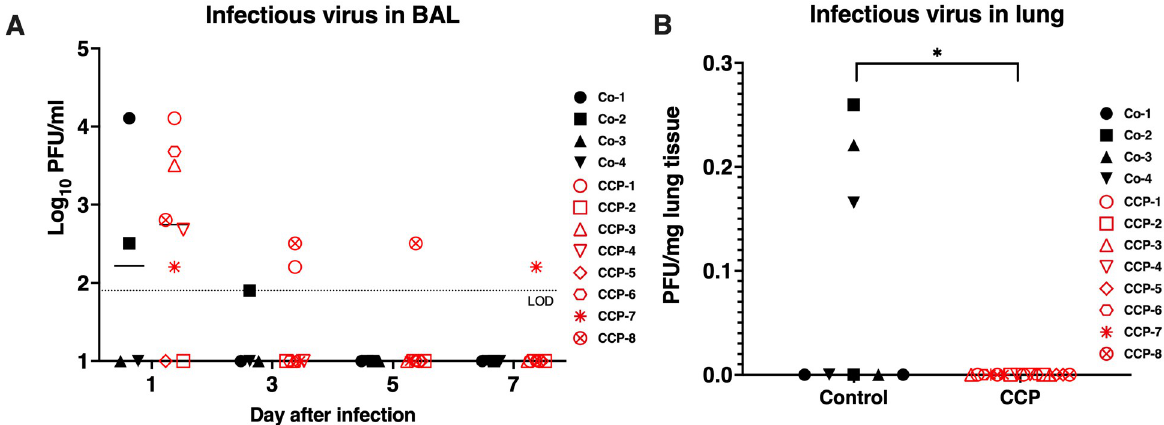
Fig 5. Effect of convalescent plasma on infectious virus titers in BAL and lung tissues. (A) Infectious virus titers in BAL supernatant (expressed as plaque-forming units (PFU) per ml) did not show any difference between the 2 study groups for any of the time points of BAL collection. Lines indicate median values. The dotted line indicates the limit of detection (LOD). (B) Infectious virus titers in lung tissues. For each animal, two snapfrozen lung specimens (one sample per left and right caudal lung lobe) were tested for infectious virus. The only 3 samples with detectable virus were all right caudal lobe samples of 3 control animals, with detection of 1 plaque; taking the dilution factor of the assay and weight of the original tissue specimen into account, this was then expressed as PFU per mg lung tissue. Comparison of both groups revealed a significant difference (p = 0.028, Mann-Whitney